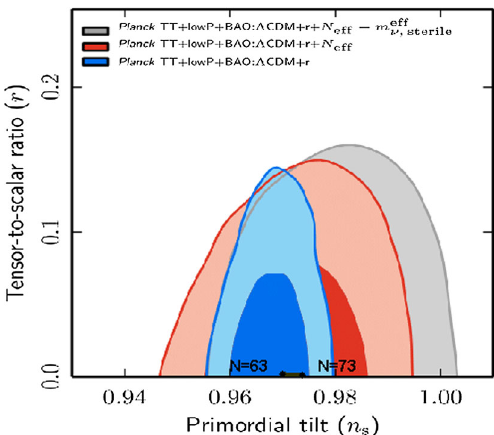
Fig. 4 Marginalizedjointconfidencecontoursfor ( n s , r ) ,atthe68and 95% CL, without the presence of running of the spectral indices. We have drawn the curve from N = 63 to 73 e-folds. (Figure courtesy of the Planck2015 Collaboration) (cid:8) (cid:7) 1 − n s + ln N ≈ 2 . Now we cannot reproduce the same 1 − n s 2 calculation as we did for the former case so as to obtain